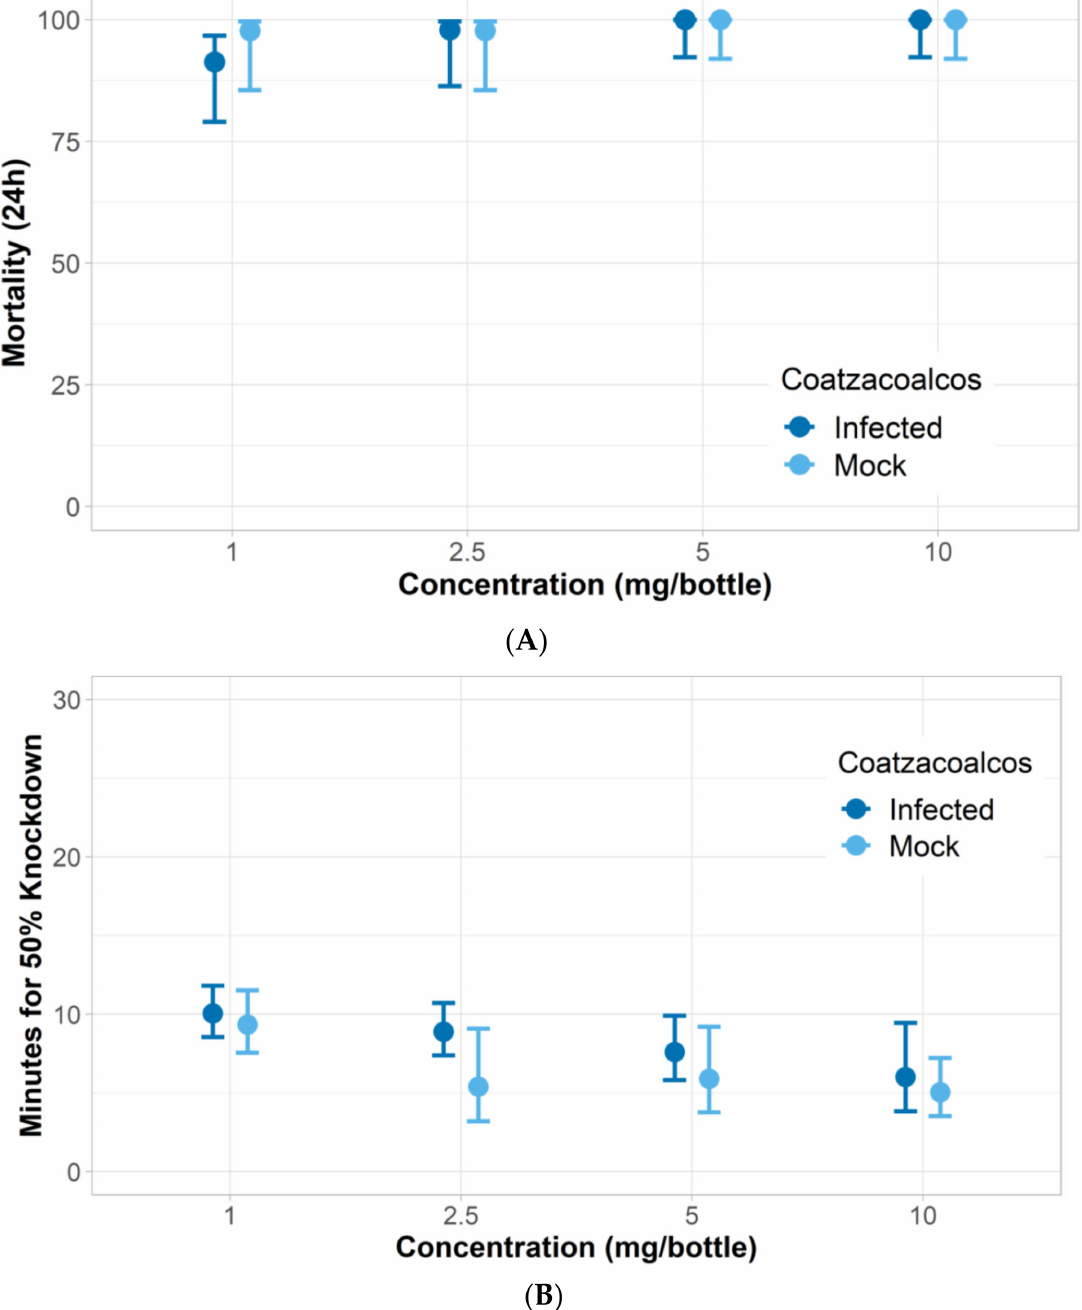
Figure 5. Response of Coatzacoalcos A. albopictus Zika-infected (infected) and uninfected (mock) mosquitoes when exposed to four concentrations of nootkatone (mg/bottle). ( A ) Mortality at 24 h and, ( B ) 50% of knockdown time in